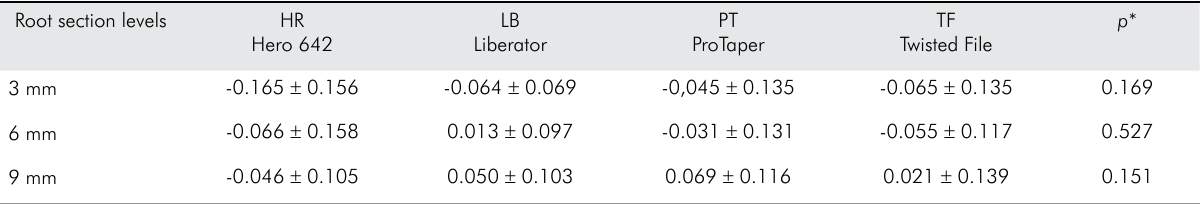
Table 3. Mean of centering ability (mm) and standard deviation among the groups and root section levels.